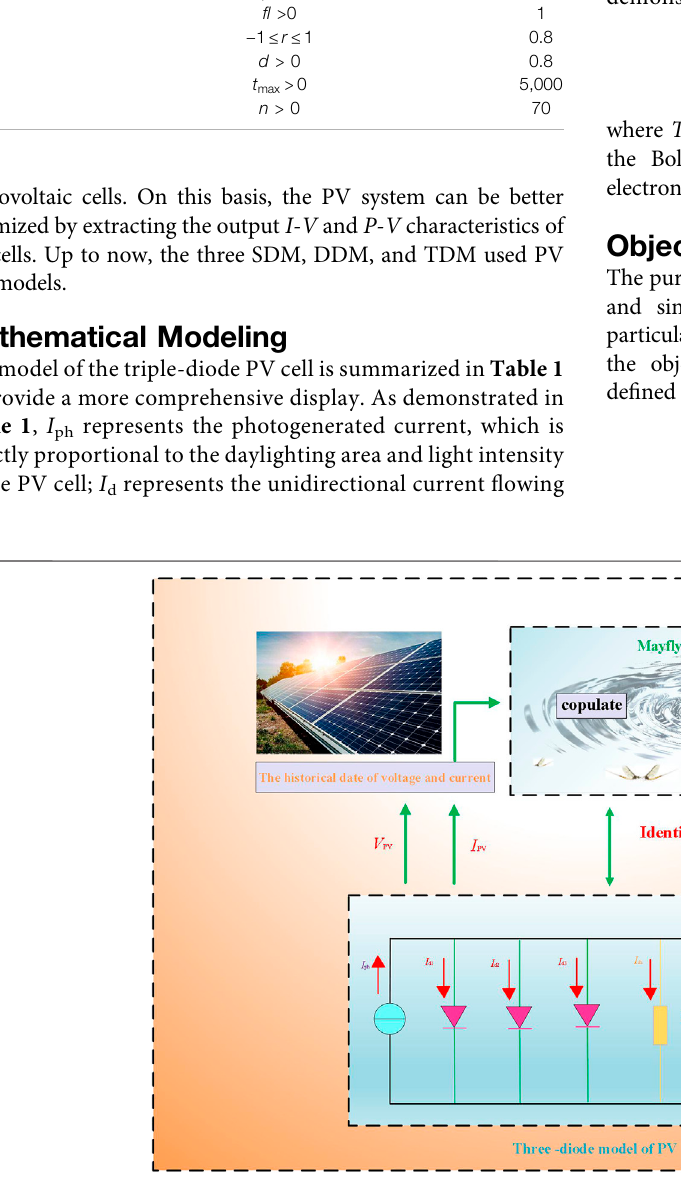
FIGURE 1 | Application process of the MA for parameter identi fi cation of the PV cell.